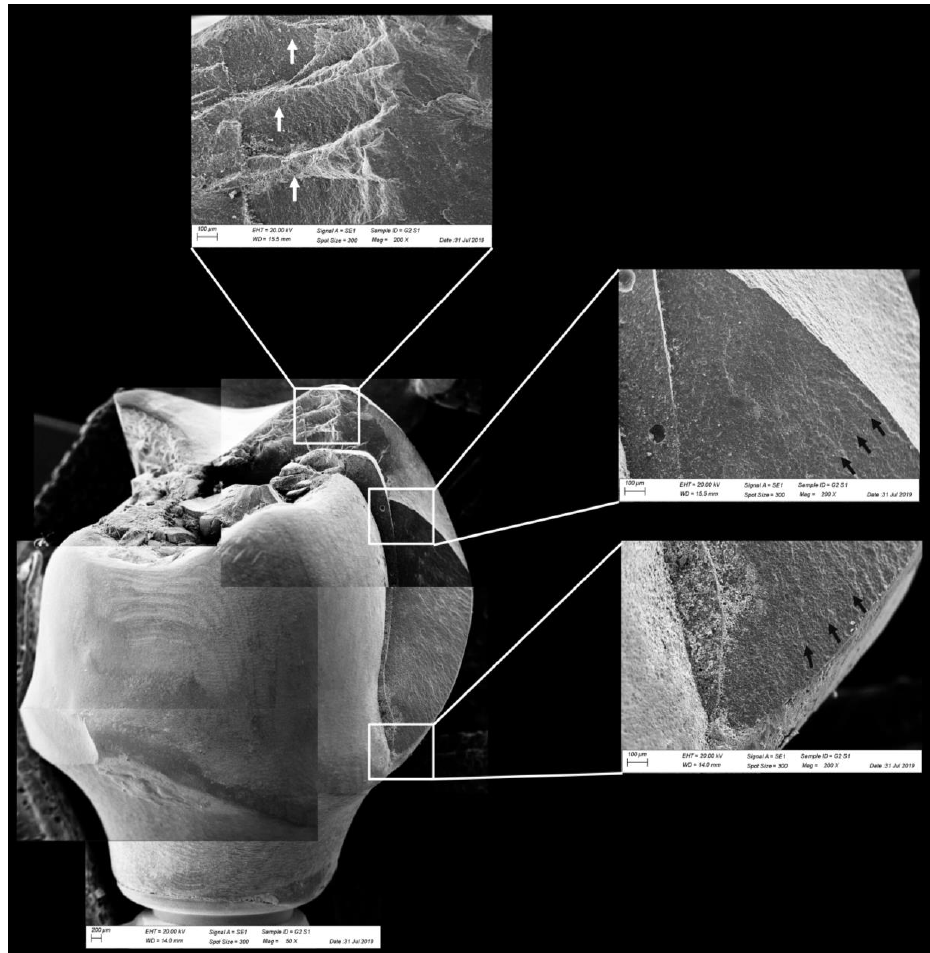
Figure 11. Fractographic analysis of a representative specimen from the CME group. The crown failed without the mesostructure involvement. The white arrows indicate the arrest lines and the black arrows indicate the hackle lines. Materials 2020 , 13 , x FOR PEER REVIEW